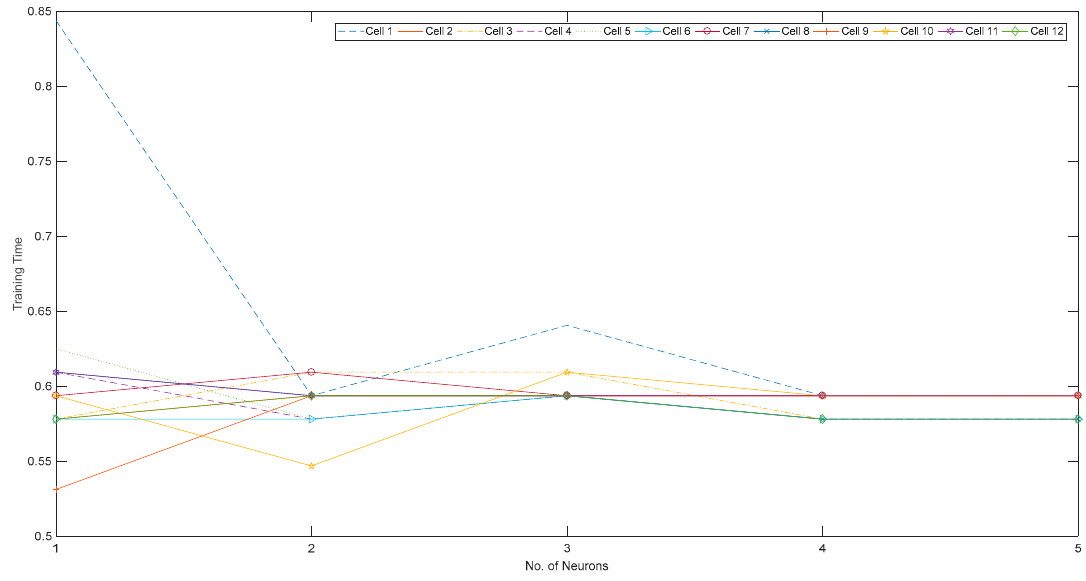
Figure 21. Training time for a 12-cell battery at 25 °C for five neurons (N0 = 200, block range = 847, sinusoidal activation function). Energies 2018 , 11 , x